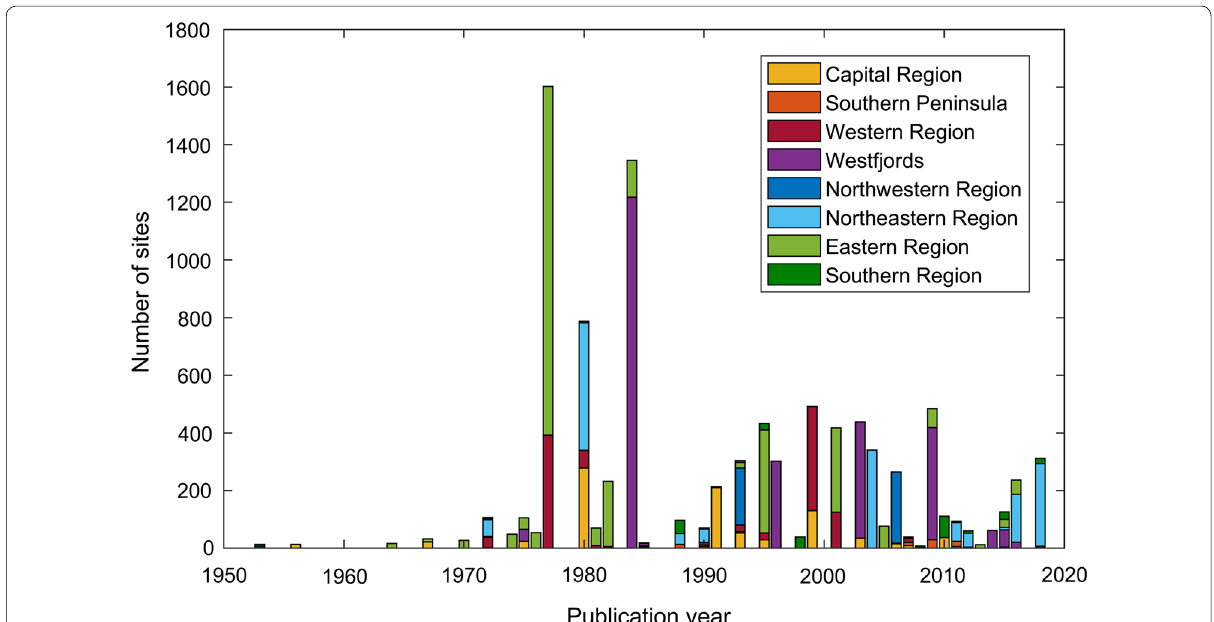
Fig. 6 Histogram of sites by publication year. Distribution of ICEPMAG sites across year of publication, coloured by geographic region (legend